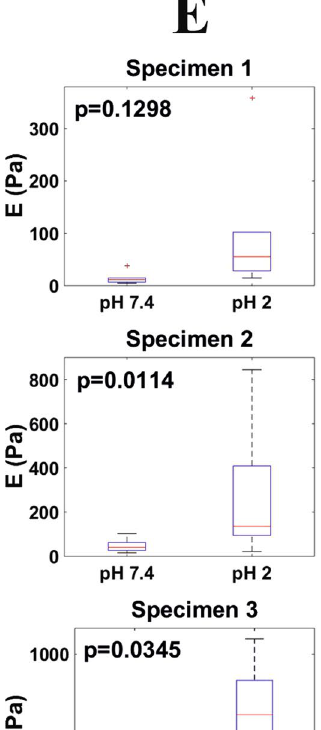
Figure 5. Distributions (n = 10) of E values obtained at both pH 7.4 and pH 2 for all investigated